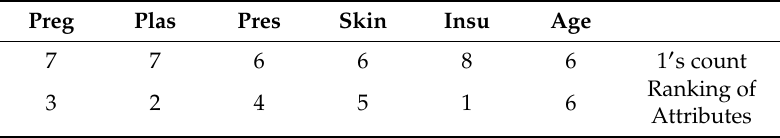
Table 20. Final Ranking of attributes after the termination of